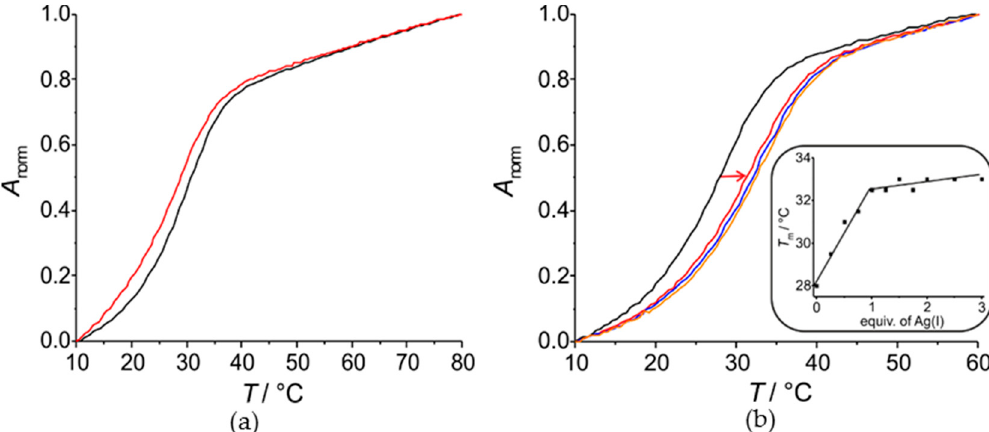
Figure 2. UV melting curves of the duplex comprising a central 6PP:pyrimidine base pair in the presence of increasing amounts of AgNO 3 (black: 0 equiv.; red: 1. equiv.; blue: 2 equiv.; orange: 3 equiv.) ( a ) 6PP:C (pH 6.8); ( b ) 6PP:T (pH 9.0). The arrow indicates the direction of the changes upon